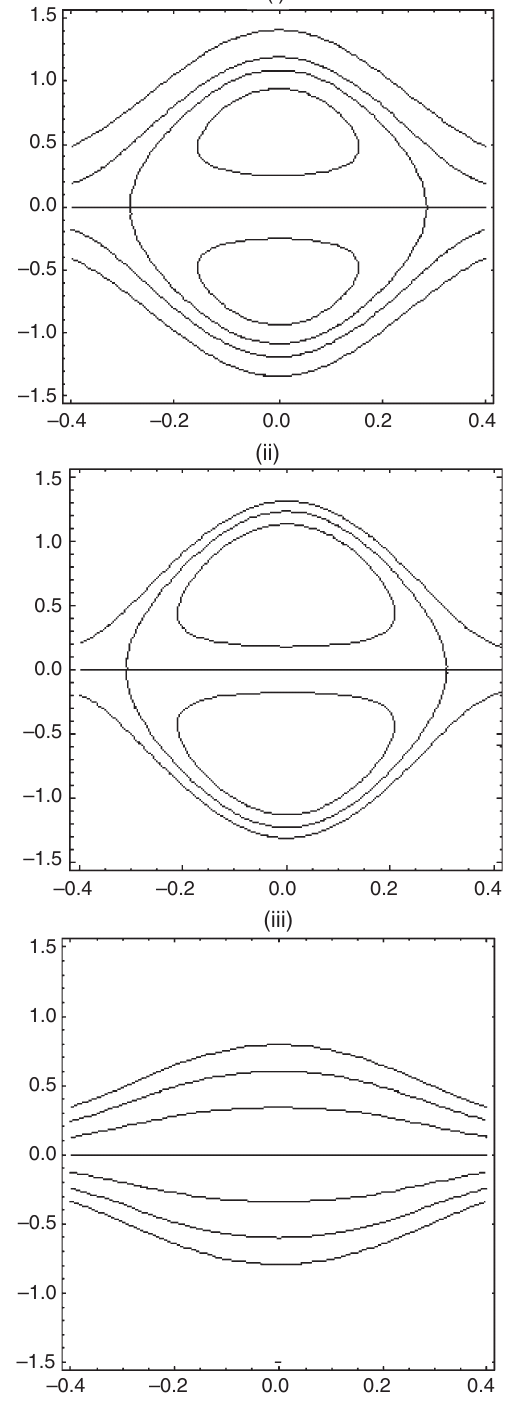
Fig. 9. Streamlines for a =0.5, b =0.5, d =1. Q = 1 . 4 and β = 0 . 1 for different y (i) y = 0 . 3, (ii) y = 0 . 5, (iii) y = 0 . 7.